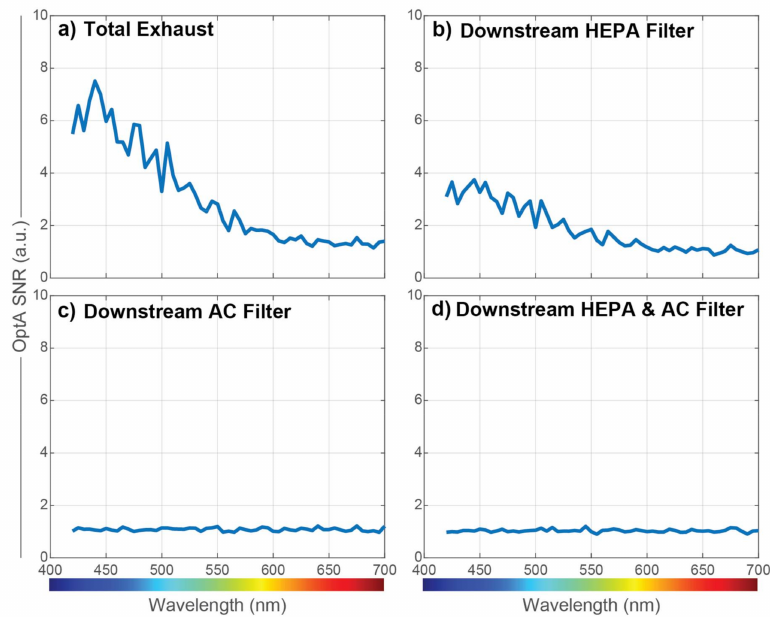
Figure 4. Sensor signal with different exhaust treatment. ( a ) Total exhaust, ( b ) Exhaust filtered by a High-Efficiency Particulate Air (HEPA) filter, ( c ) Exhaust filtered by an Activated Carbon filter, ( d ) Exhaust filtered by a HEPA filter and an Activated Carbon Filter in